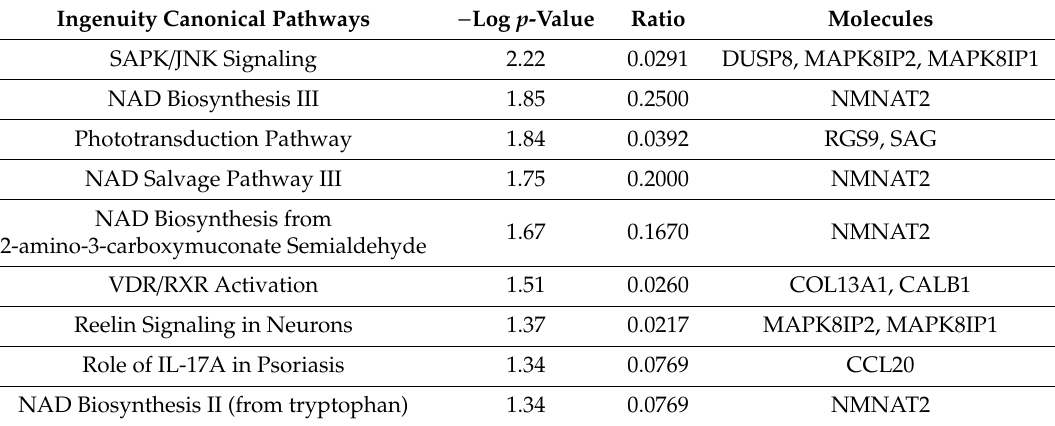
Table 5. Canonical